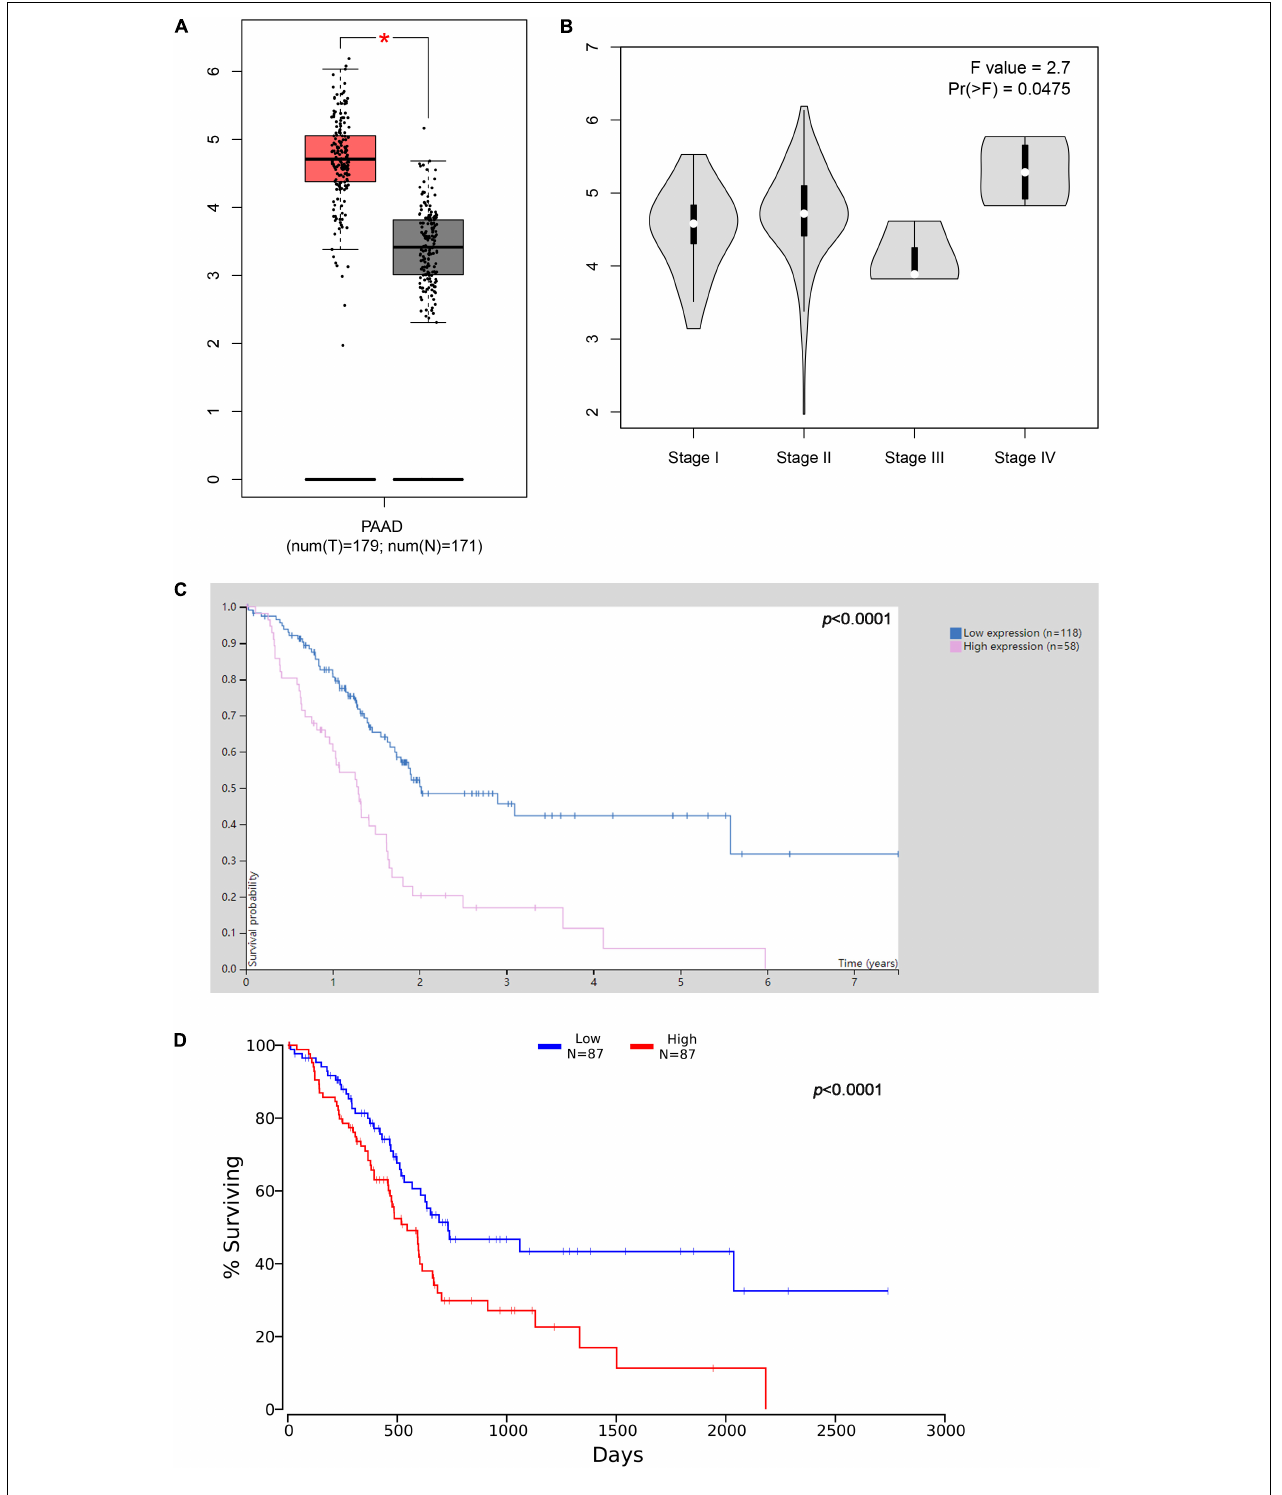
FIGURE 1 | The expression level of importin 7 (IPO7) in pancreatic adenocarcinoma (PAAD) and its significance. (A) The expression of IPO7 in pancreatic cancer tissues in The Cancer Genome Atlas (TCGA) database was analyzed through Gene Expression Profiling Interactive Analysis (GEPIA) database (http://gepia2.cancer-pku.cn/#index). (B) The expression levels of IPO7 in pancreatic cancer tissues of different clinical stages were analyzed via GEPIA database. (C,D) Human Protein Atlas database (http://www.proteinatlas.org/) and Oncolnc database (www.oncolnc.org) indicated that high expression of IPO7 was associated with shorter survival time of patients with pancreatic cancer * p <